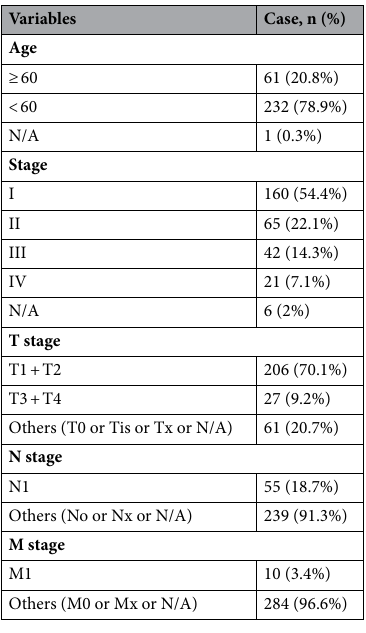
Table 2. Basic characteristics of TCGA-CESC